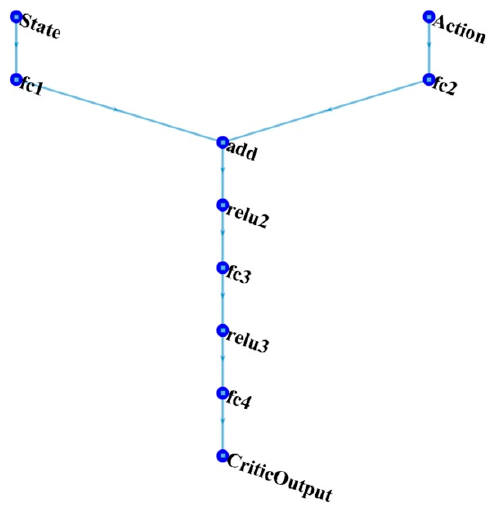
Figure 3. Creation of the deep neural network—MATLAB syntax code example.